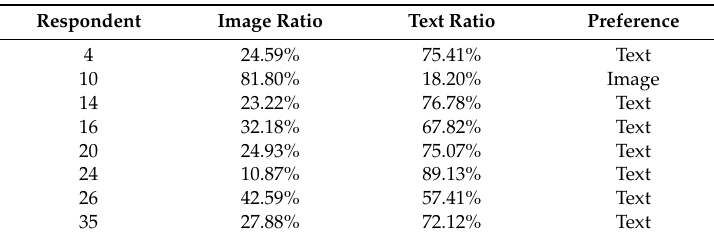
Table 11. Respondents with medium anxiety.